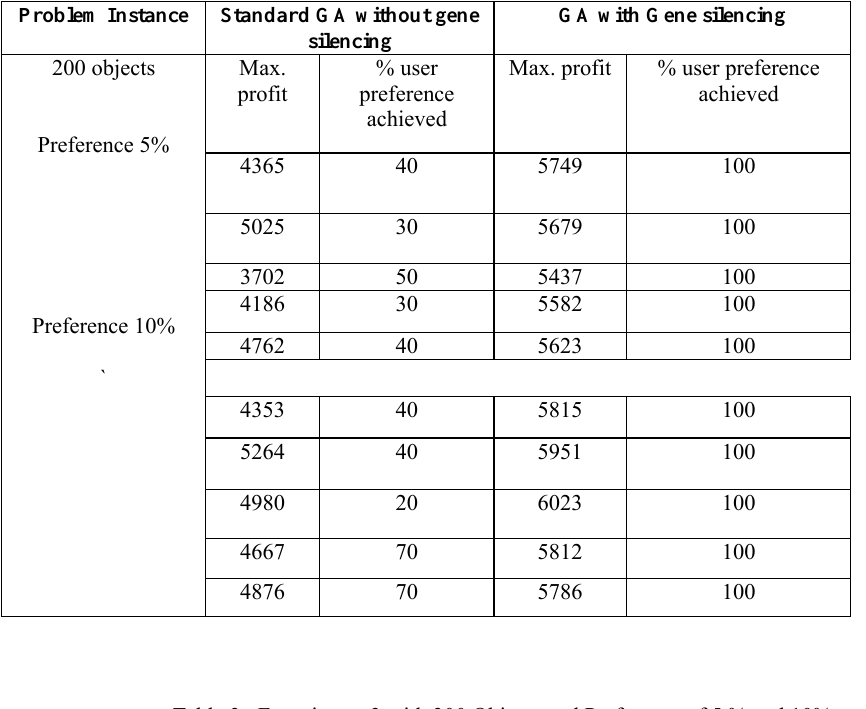
Table 3. Experiment-3 with 300 Objects and Preference of 5 % and